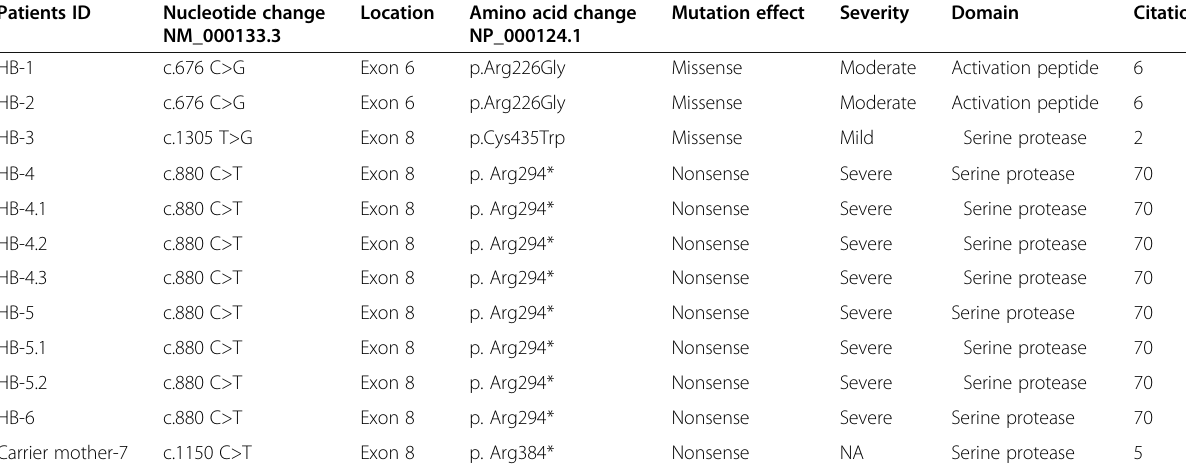
Table 1 Characterization of the variants identified in the families with HB Patients ID